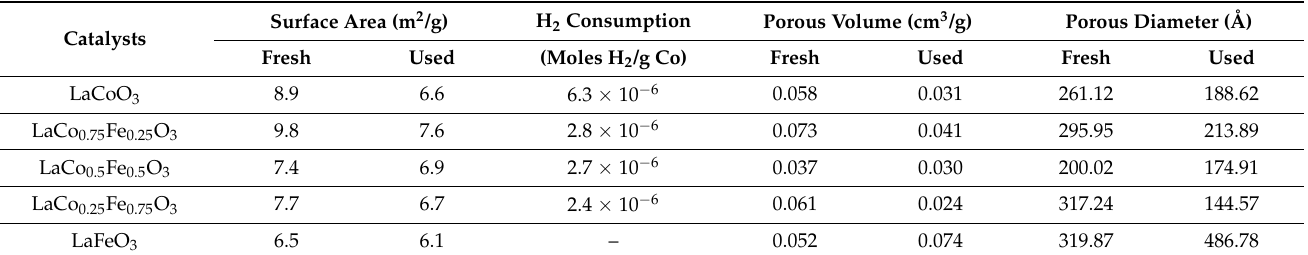
Table 2. Results of the BET isotherm analysis and H 2 consumption from the TPR